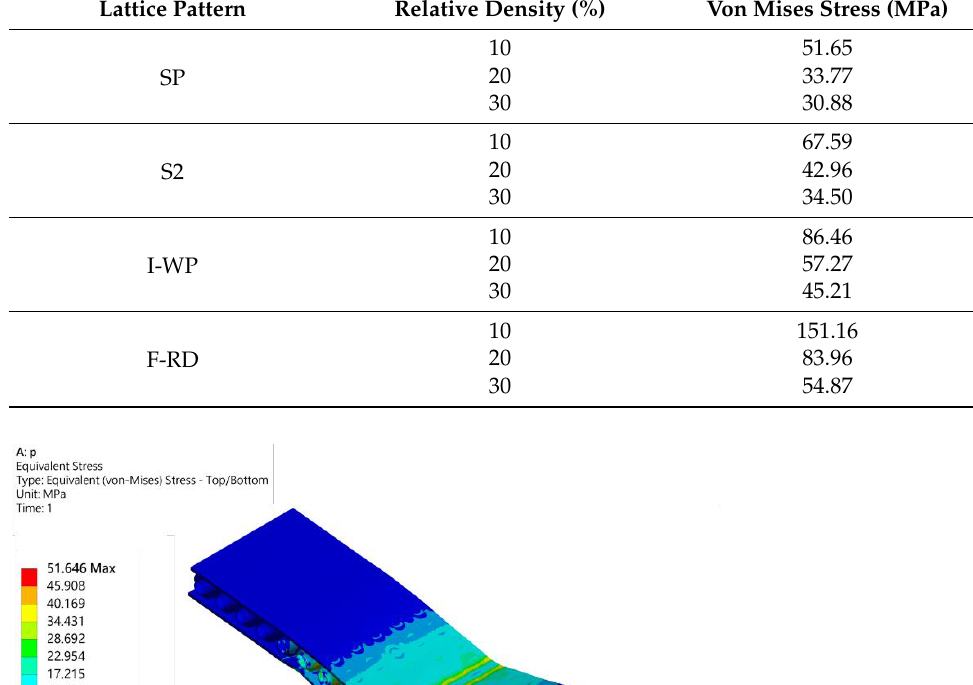
Table 10. von Mises stresses of the four TPMS lattices at different relative densities.